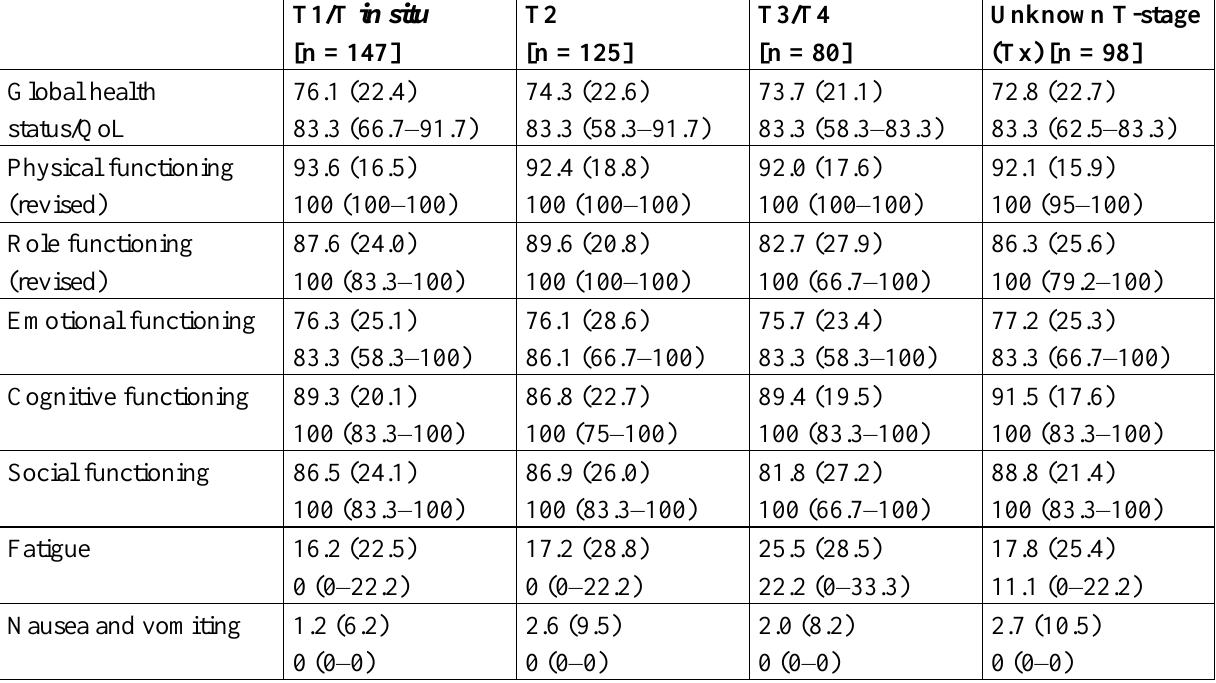
Table 2. Mean (SD) and median (25th–75th percentiles) EORTC QLQ-C30 scores of German melanoma patients at baseline (Q1; OVIS I) according to tumor